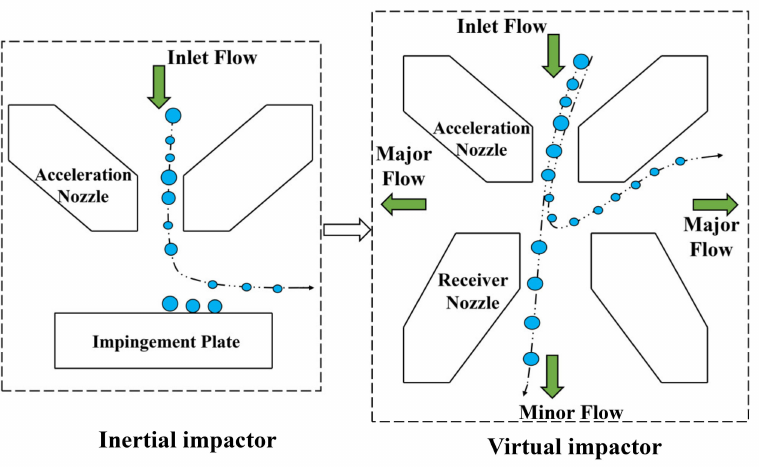
Figure 1. Structural evolution of the